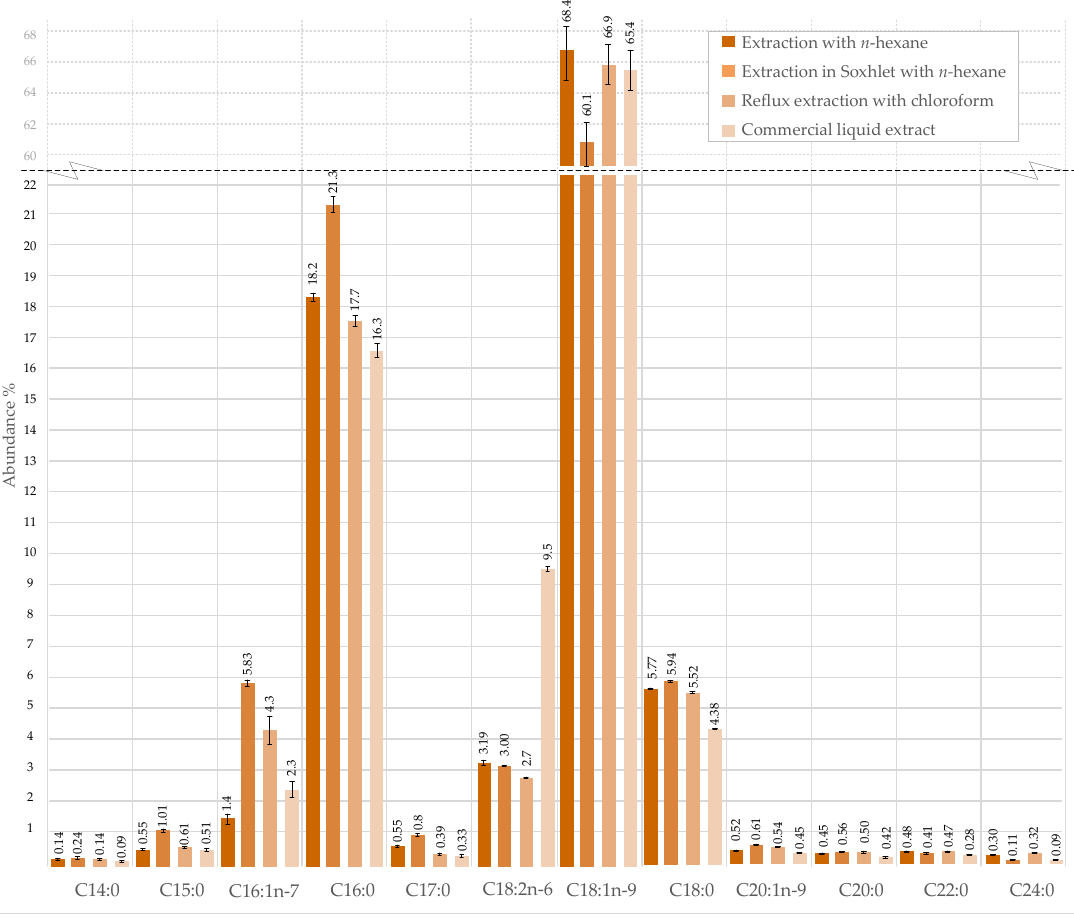
Figure 5. Graphical illustration of fatty acids profiles of lipids from spores of G. lucidum. The contents of the saturated fatty acids (SFAs), monounsaturated fatty acids (MUFAs) and polyunsaturated fatty acids (PUFAs) were calculated for each extract (Table 3). Table 3. Groups of fatty acids from the composition of samples of Ganoderma lucidum obtained with different extraction processes.